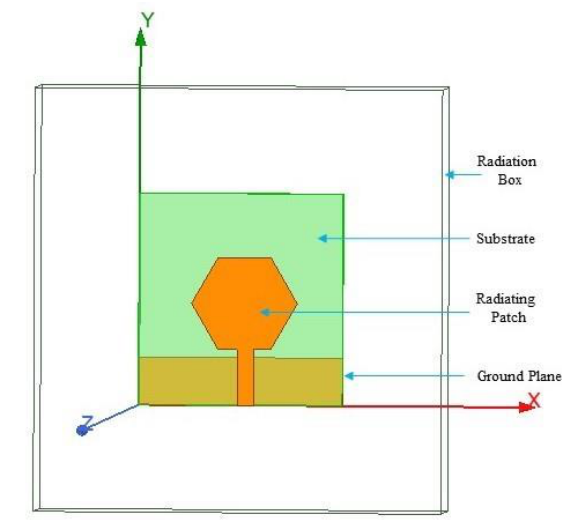
Fig. 2. Geometry of proposed antenna structure